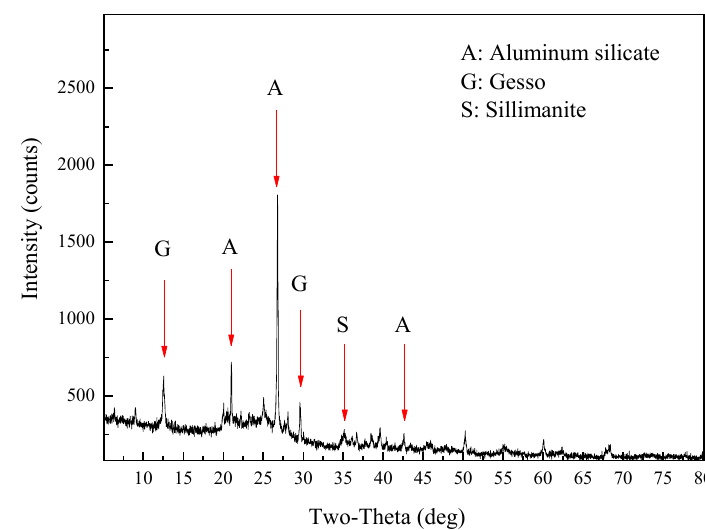
Figure 1. X-ray di ff raction patterns of the coke powder used in this study. Figure 1. X-ray diffraction patterns of the coke powder used in this study.